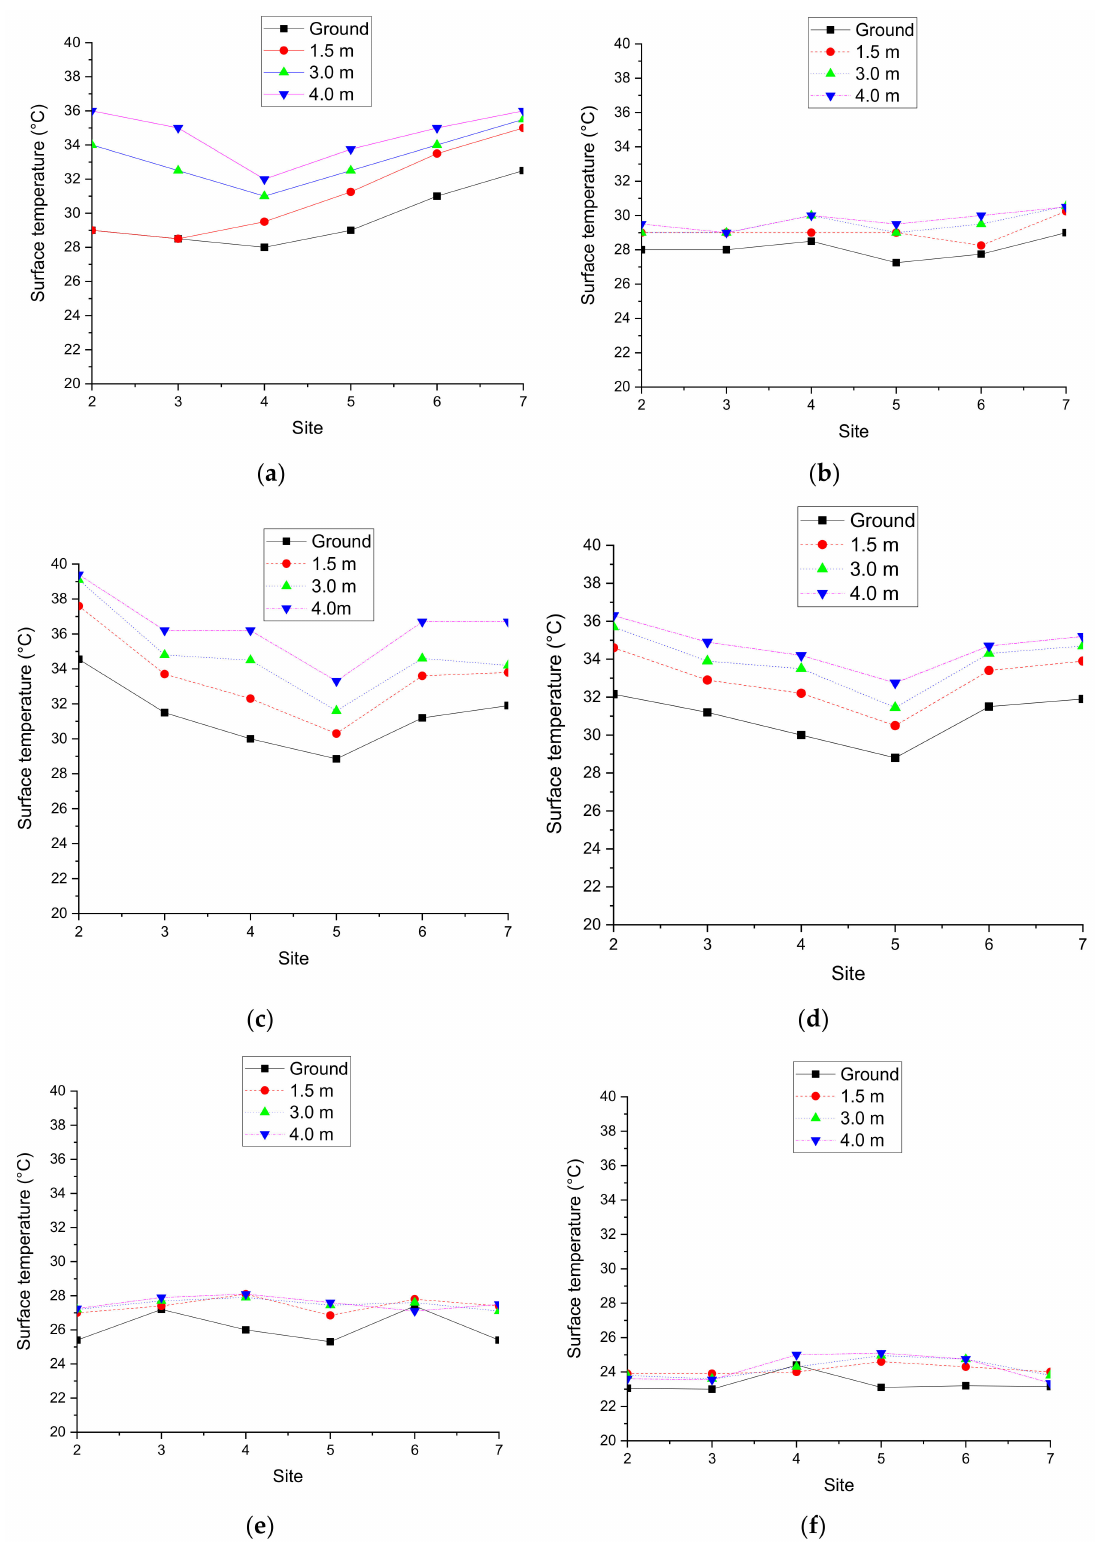
Figure 8. Temperature profiles at di ff erent heights: ( a ) 24 August, 15:00 (sunny); ( b ) 25 August, 7:00 (sunny); ( c ) 25 August, 15:00 (sunny); ( d ) 25 August, 19:10 (sunny); ( e ) 26 August, 7:30 (started raining); ( f ) 26 August, 13:00